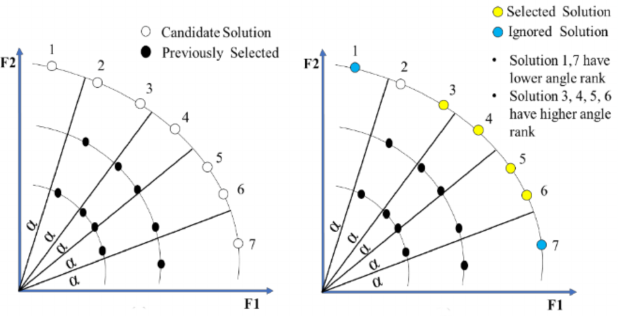
Figure 2. The selected solution in solution space by